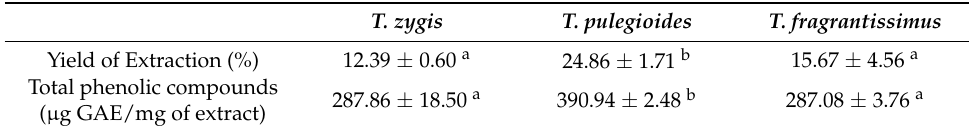
Table 2. Yield and total phenolic compounds of aqueous extracts of T. zygis , T. pulegioides and T. fragrantissimus